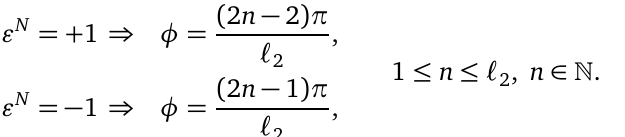
Figure 1: A pictorial illustration of semi-cyclic transfer matrix T sc iliary space is denoted as a , while φ corresponds to the twist matrix. Different values of parameter β in semi-cyclic representation are written explicitly next to each phys- ical